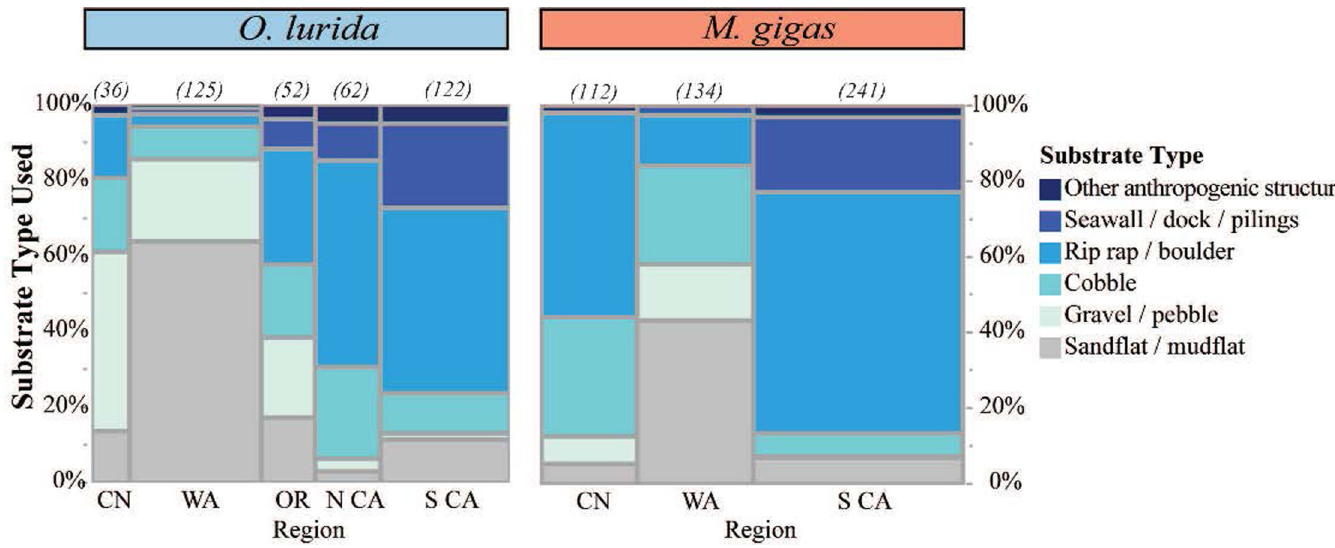
Fig 14. Proportion of substrate types used across regions for both oysters. The number of records for each species and region is shown in parentheses above each column. Abbreviations: CN = Canada, WA = Washington, OR = Oregon, N CA / S CA = Northern / Southern California. Substrate types are arranged from smallest (bottom) to largest (top); details on substrate type definitions are in the